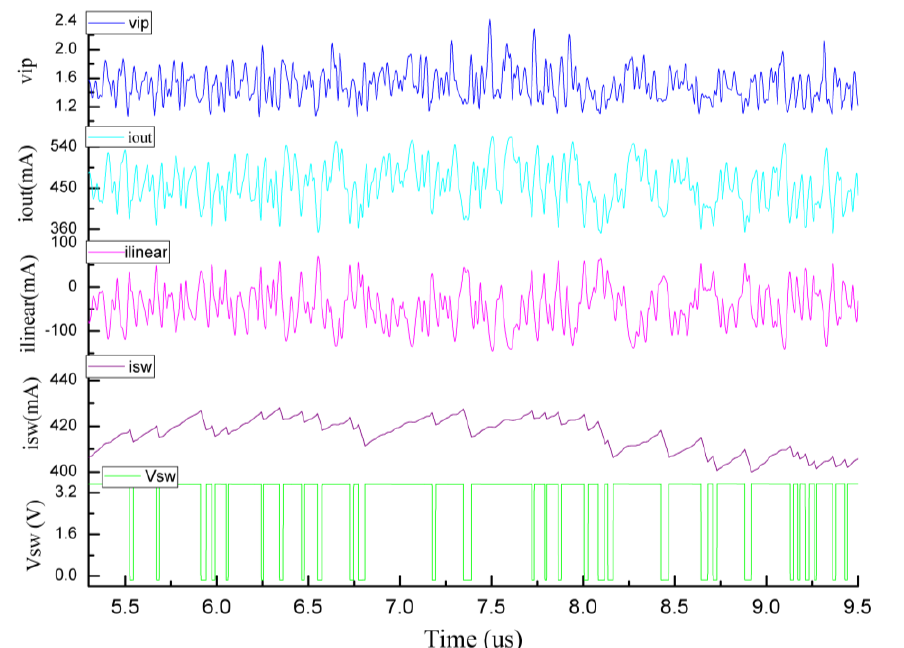
Appl. Sci. 2022 , 12 , x FOR PEER REVIEW 11 of 13